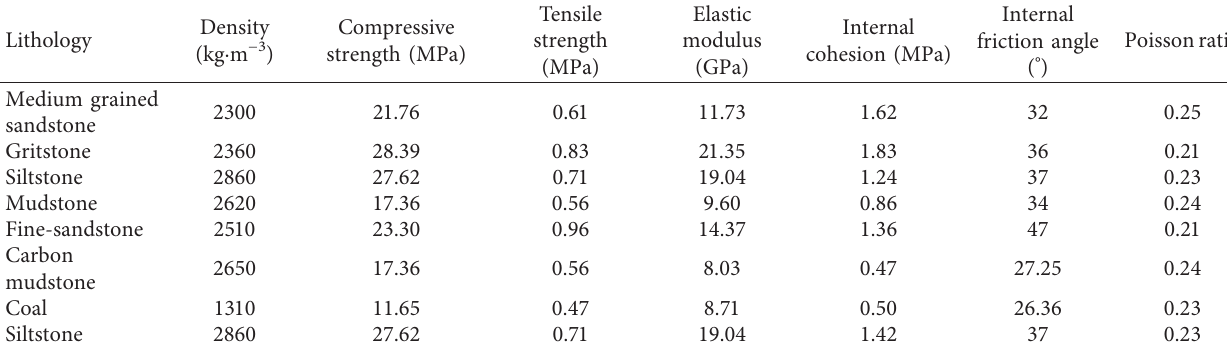
Figure 6: Numerical calculation model diagram of no. 130203 working Table 3: Physical and mechanical parameter table of numerical model materials.